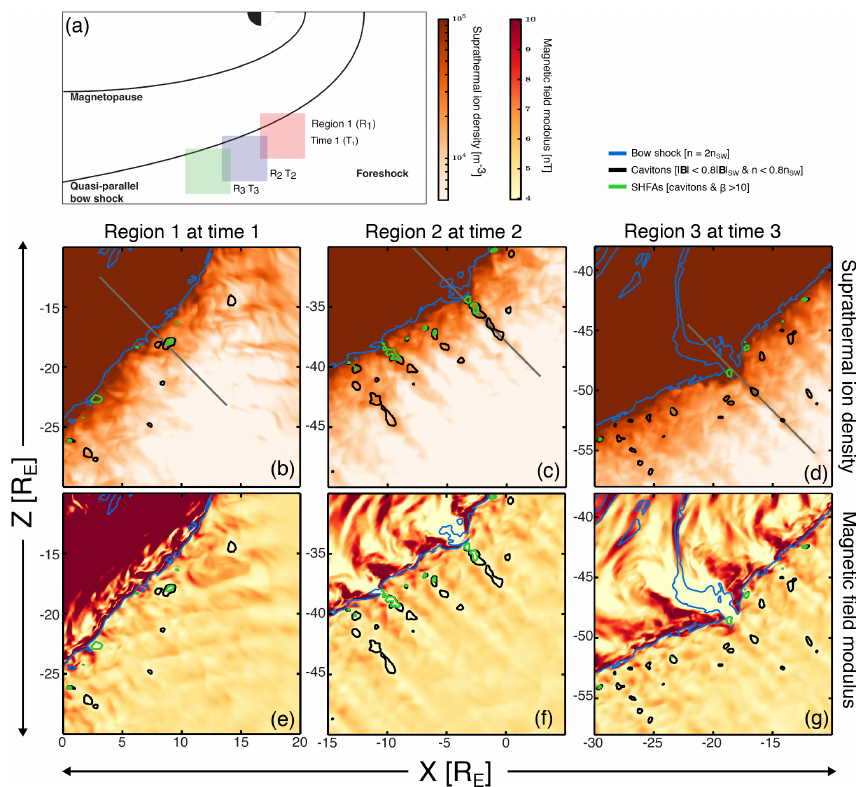
Figure 2. Evolution of cavitons, SHFAs, and a magnetosheath cavity in the Vlasiator simulation run. To track the evolution of the same structures, panels (b) – (d) correspond to a fixed dimension 20 × 20 R E box at three separate locations and time steps, as illustrated in panel (a) . The times are T 1 = 860s (Region R 1 ), T 2 = 1105s (Region R 2 ), and T 3 = 1350s (Region R 3 ). Panels (b) – (d) and (e) – (g) correspond to suprathermal ion density and magnetic field magnitude, respectively. The contours represent the bow shock (blue), cavitons (black), and SHFAs (green). The criteria for identifying each of these are provided in the legend, located in the top right corner. The three grey lines are positions of profiles chosen for further